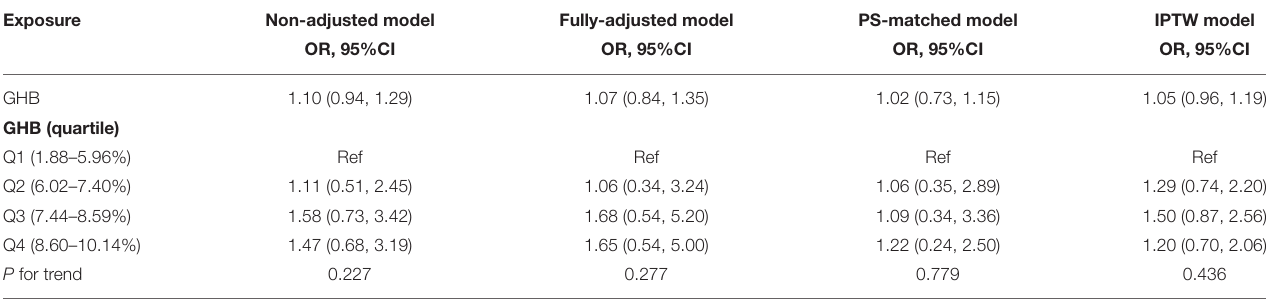
TABLE 2 | Trend of model-based odds ratio (OR) in the unadjusted, fully adjusted, propensity score (PS)-matched, and inverse probability treatment weighting (IPTW) models.